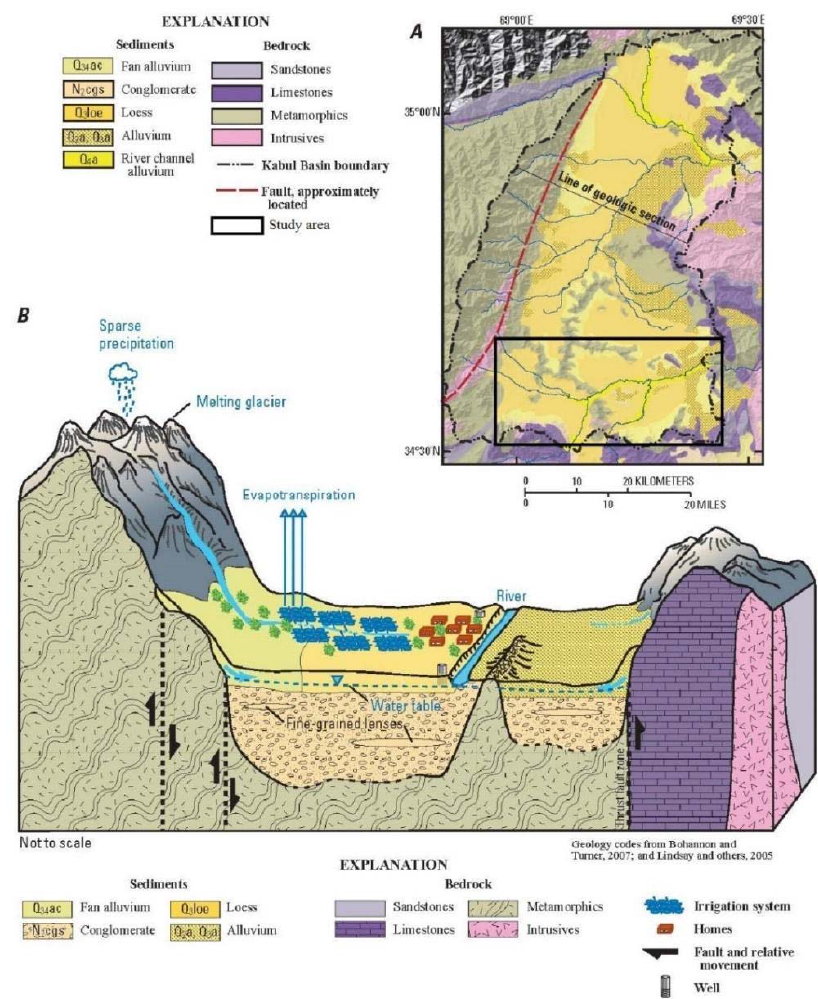
Figure 4. Geology map ( A ) and conceptualized hydro geologic cross section ( B ) of the study area [50].